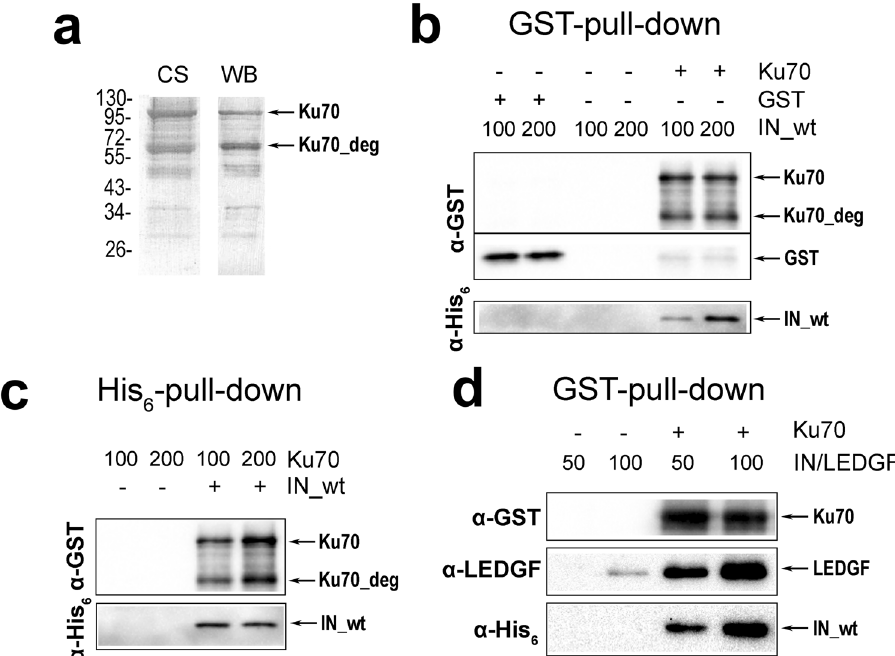
Figure 1. Analysis of the purity of recombinant preparation of Ku70 and its interaction with HIV-1 IN. ( a ) Recombinant N-GST-Ku70 protein after glutathione-sepharose purification analyzed by SDS PAGE with subsequent Coomassie blue staining (CS) and Western blot analysis with anti-GST antibody (WB). ( b ) Interaction between IN and Ku70 analyzed by a GST-pull-down assay. IN concentrations (nM) are marked above; Ku70 and GST were taken at 100 nM concentrations. ( c ) Interaction between IN and Ku70 analyzed by a His 6 -pull-down assay. Ku70 concentrations (nM) are marked above; IN was taken at 100 nM concentration. ( d ) Formation of the triple IN/LEDGF/Ku70 complex analyzed by GST-pull-down assay; 100 nM Ku70 was used, concentration of the preformed IN/LEDGF complex is marked